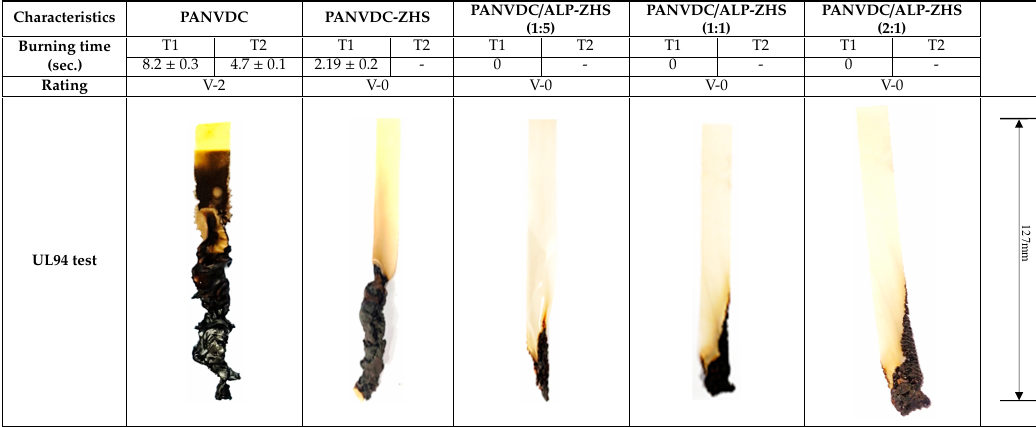
Burning time (sec.)